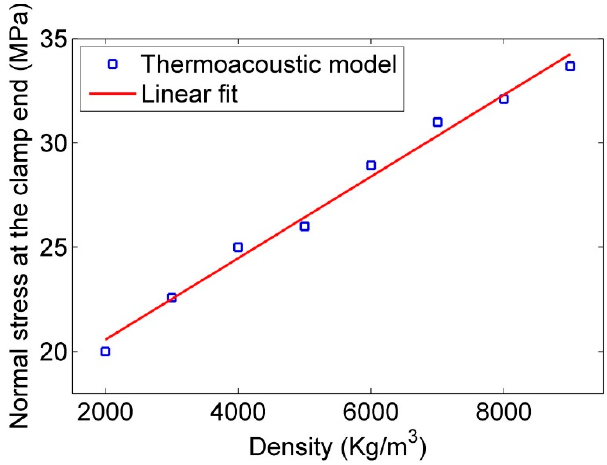
(cid:2778) (cid:2778) ). ). (cid:2778) ). (cid:2168) (cid:2781) ). L 4 (cid:2168) (cid:2781) (cid:2168) (cid:2781)